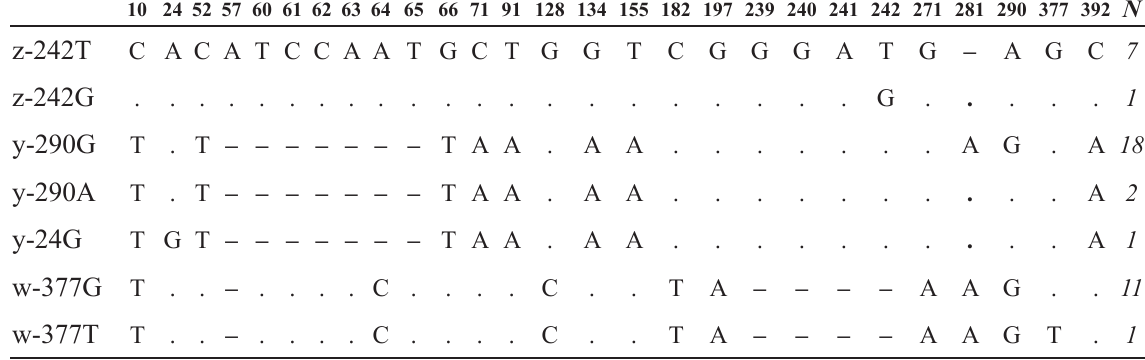
Table 3. Variable sites in the 460 bp long alignment of i56 sequences from Spongilla lacustris (Linnaeus, 1759). Seven varieties, designated z-242T, z-242G, y-290G, y-290A, y-24G, w-377G and w-377T, are found, with a total of 27 variable sites in the alignment. A dot indicates identity with the reference sequence (z-242T), a dash indicates an indel, and N is the number of specimens found of this